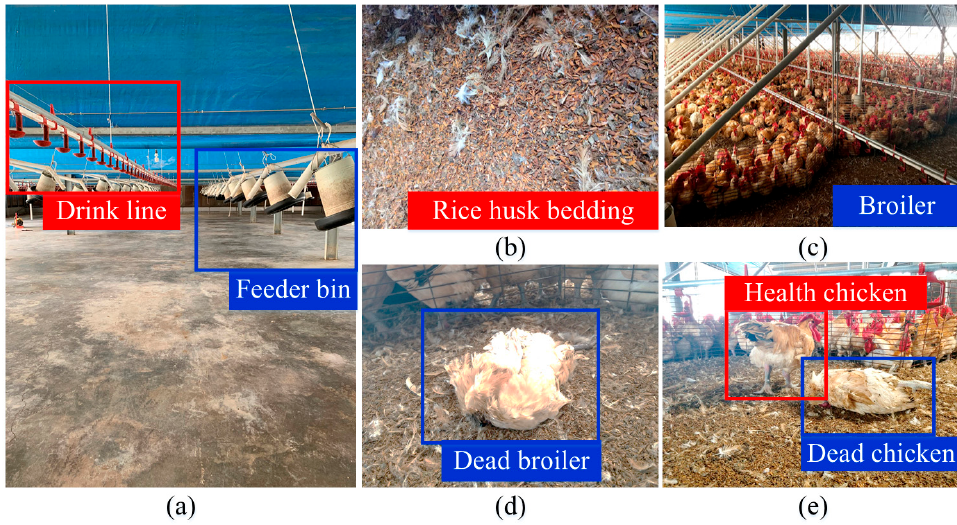
Figure 11. Experimental environments in which the developed system was used: ( a ) poultry house environment, ( b ) rice husk bedding, ( c ) experimental objects (broilers), ( d ) dead broiler, and ( e ) healthy and dead chickens.